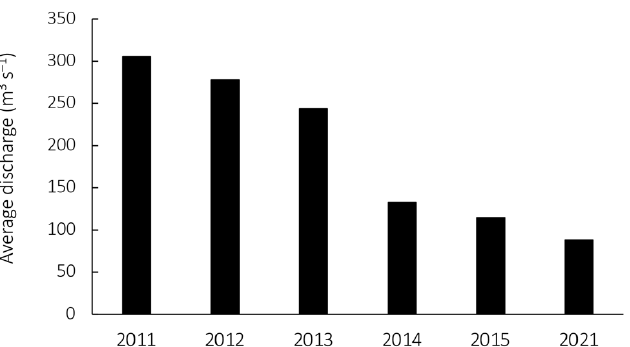
Figure 2. Average discharge at USGS site 11,455,420 at Rio Vista (657, station 8) for the 30-days prior to the date of sampling for each year indicated. Note the clear trend for drier conditions over time.